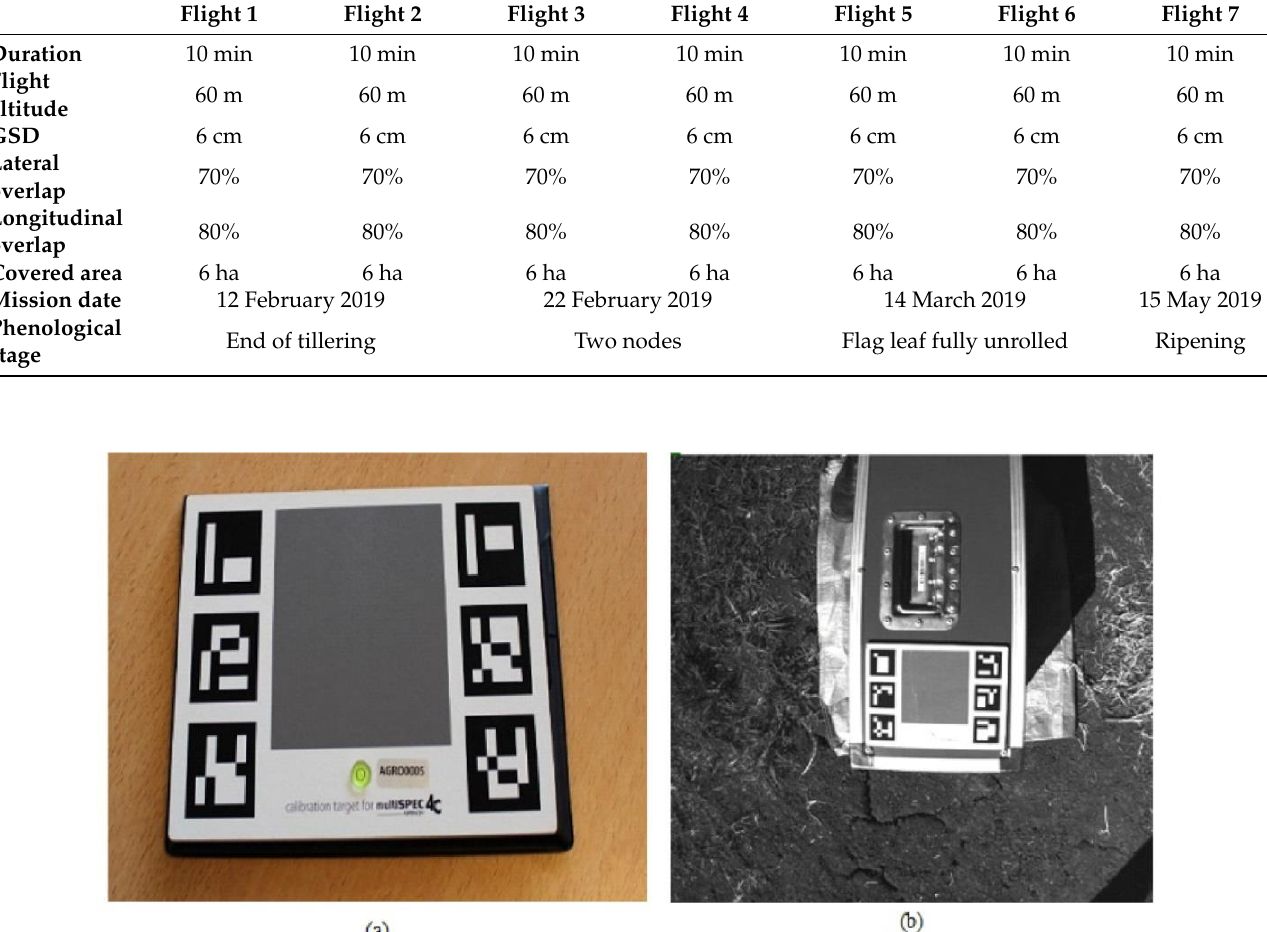
Figure 5. ( a ) MultiSPEC 4C Calibration target; ( b ) Image taken on the field during the calibration process.